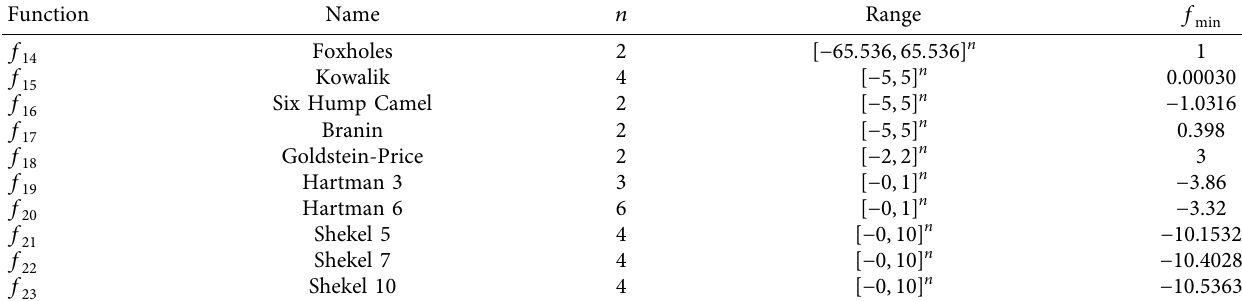
Table 3: Fixed-dimension multimodal benchmark functions.